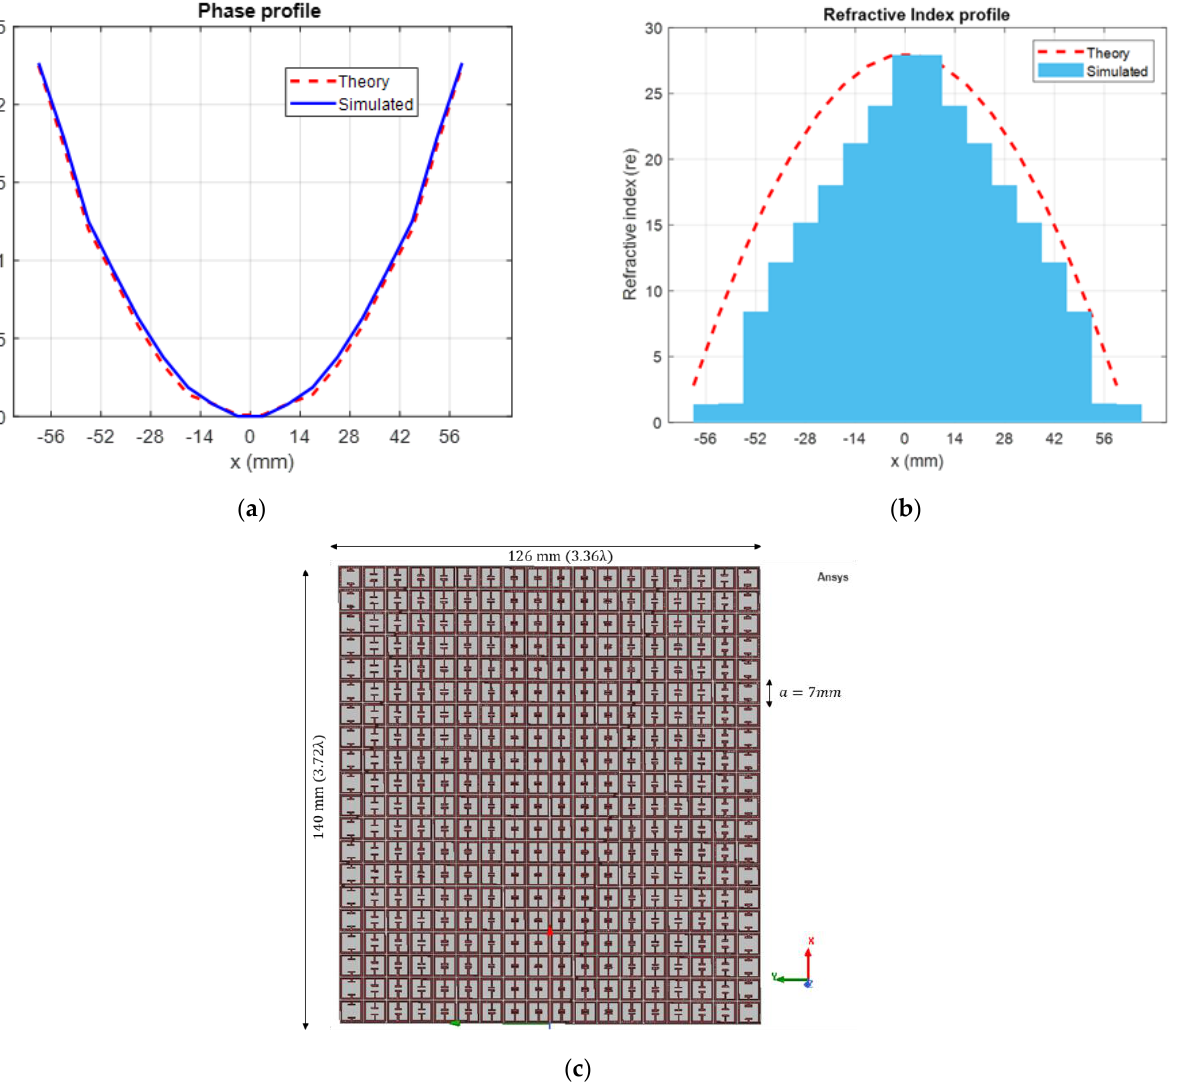
Figure 5. ( a ) Theoretical and simulated phase gradient ( b ) Theoretical and extracted refractive index gradient ( c ) Proposed 1D GRIN metasurface lens design.